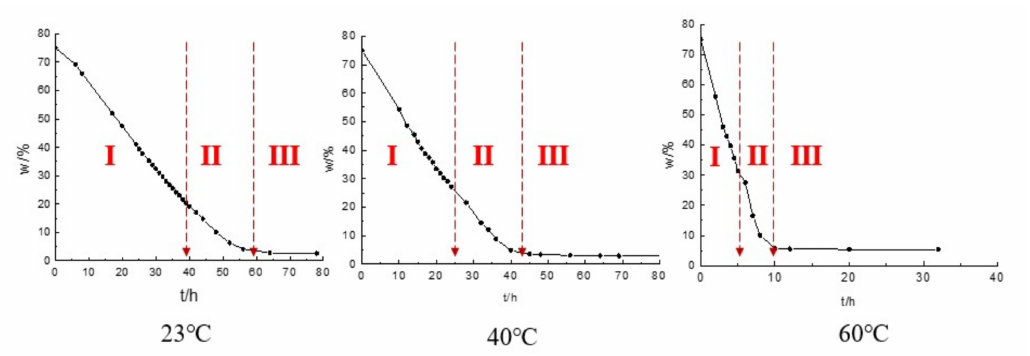
Figure 5. Three stage diagram of soil moisture